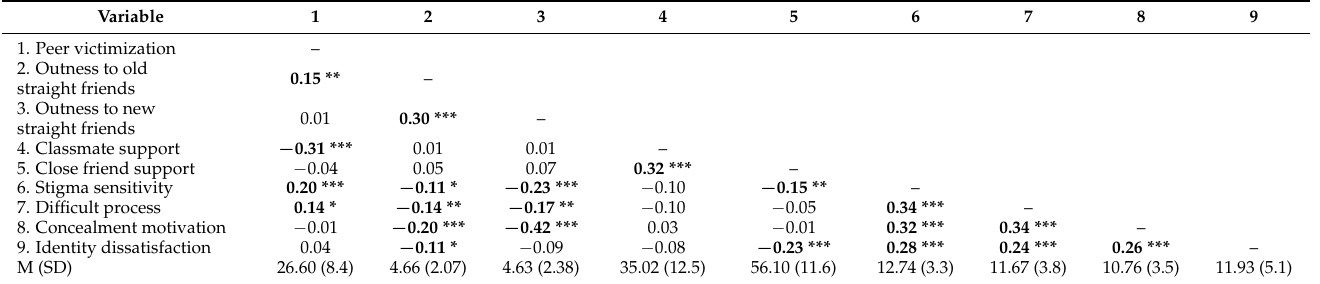
Table 2. Bivariate correlations and descriptive statistics for the main study variables.